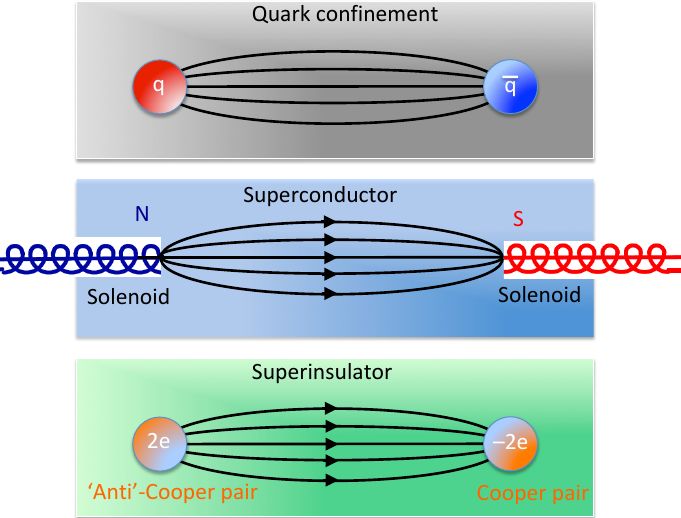
Figure 1. Dual Mandelstam’t Hooft–Polyakov confinement. From top to bottom: quark confinement by chromo-electric strings; magnetic tube (Abrikosov vortex) that forms in a superconductor between two magnetic monopoles; electric string that forms in a superinsulator between the Cooper pair and anti-Cooper pair. The lines are the force lines for magnetic and electric fields respectively. In all cases the energy of the string (the binding energy) is proportional to the distance between either the monopoles or the